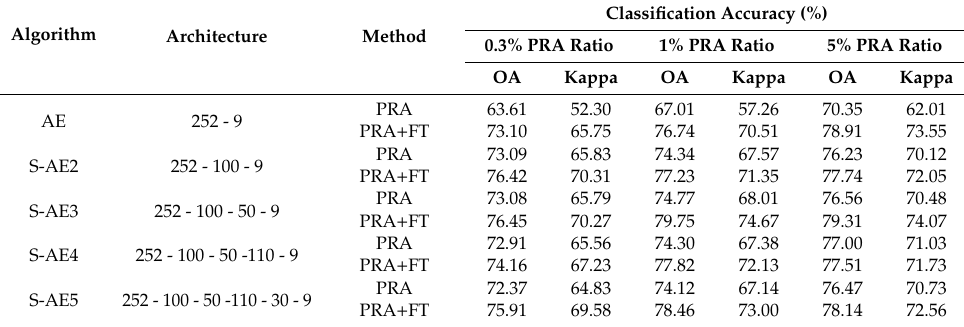
Table 3. Classification accuracy using S-SAEs with di ff erent depths.